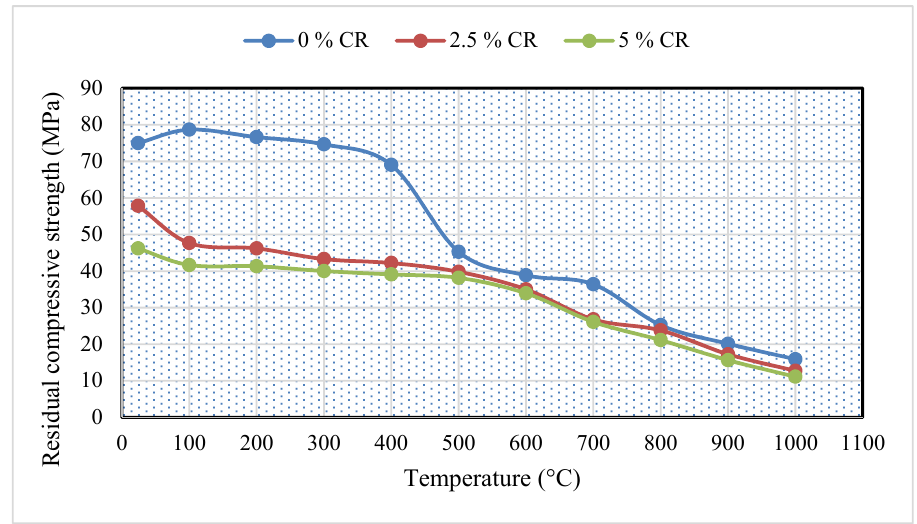
Figure 3. Residual compressive strength of CR ‐ ECC.